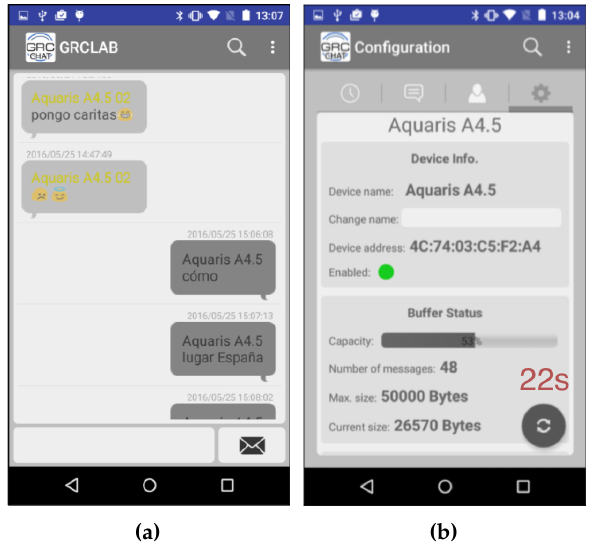
Figure 1. Several screenshots of the GRChat app. ( a ) a typical chat conversation; and ( b ) status of message interchange, showing the remaining time for end the transmission.